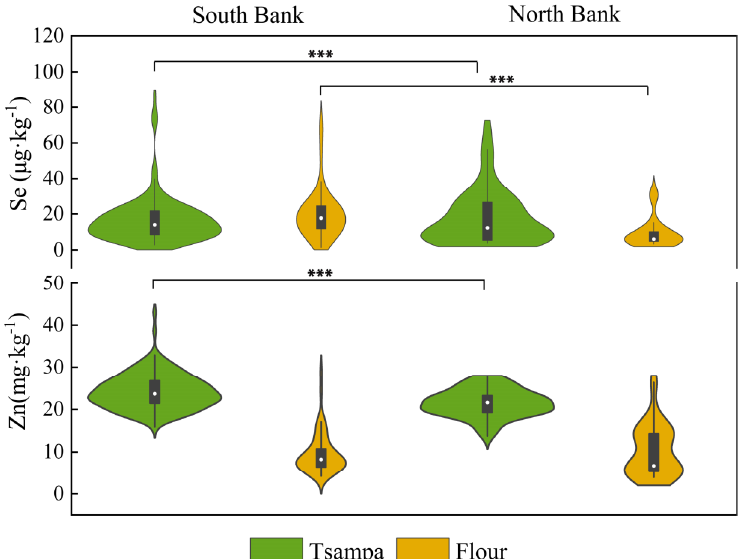
Figure 3. Se and Zn concentrations of staple grains on both banks of Yarlung Zangbo River (Boxes within the violins show the interquartile range, and medians are marked as white dots; whiskers indicate 1.5 times of interquartile range; *** indicates that the p < 0.01). Tsampa was a good potential source of Zn, with an average Zn concentration (23.57